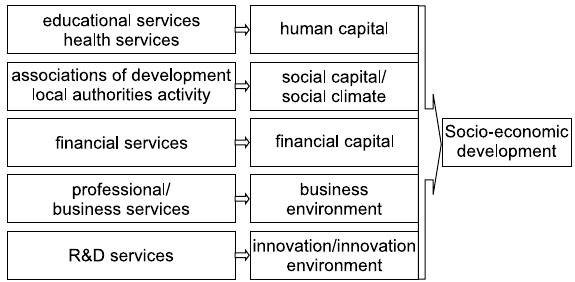
Fig. 1. Model of the impact of modern services on socio-economic development. Source: own